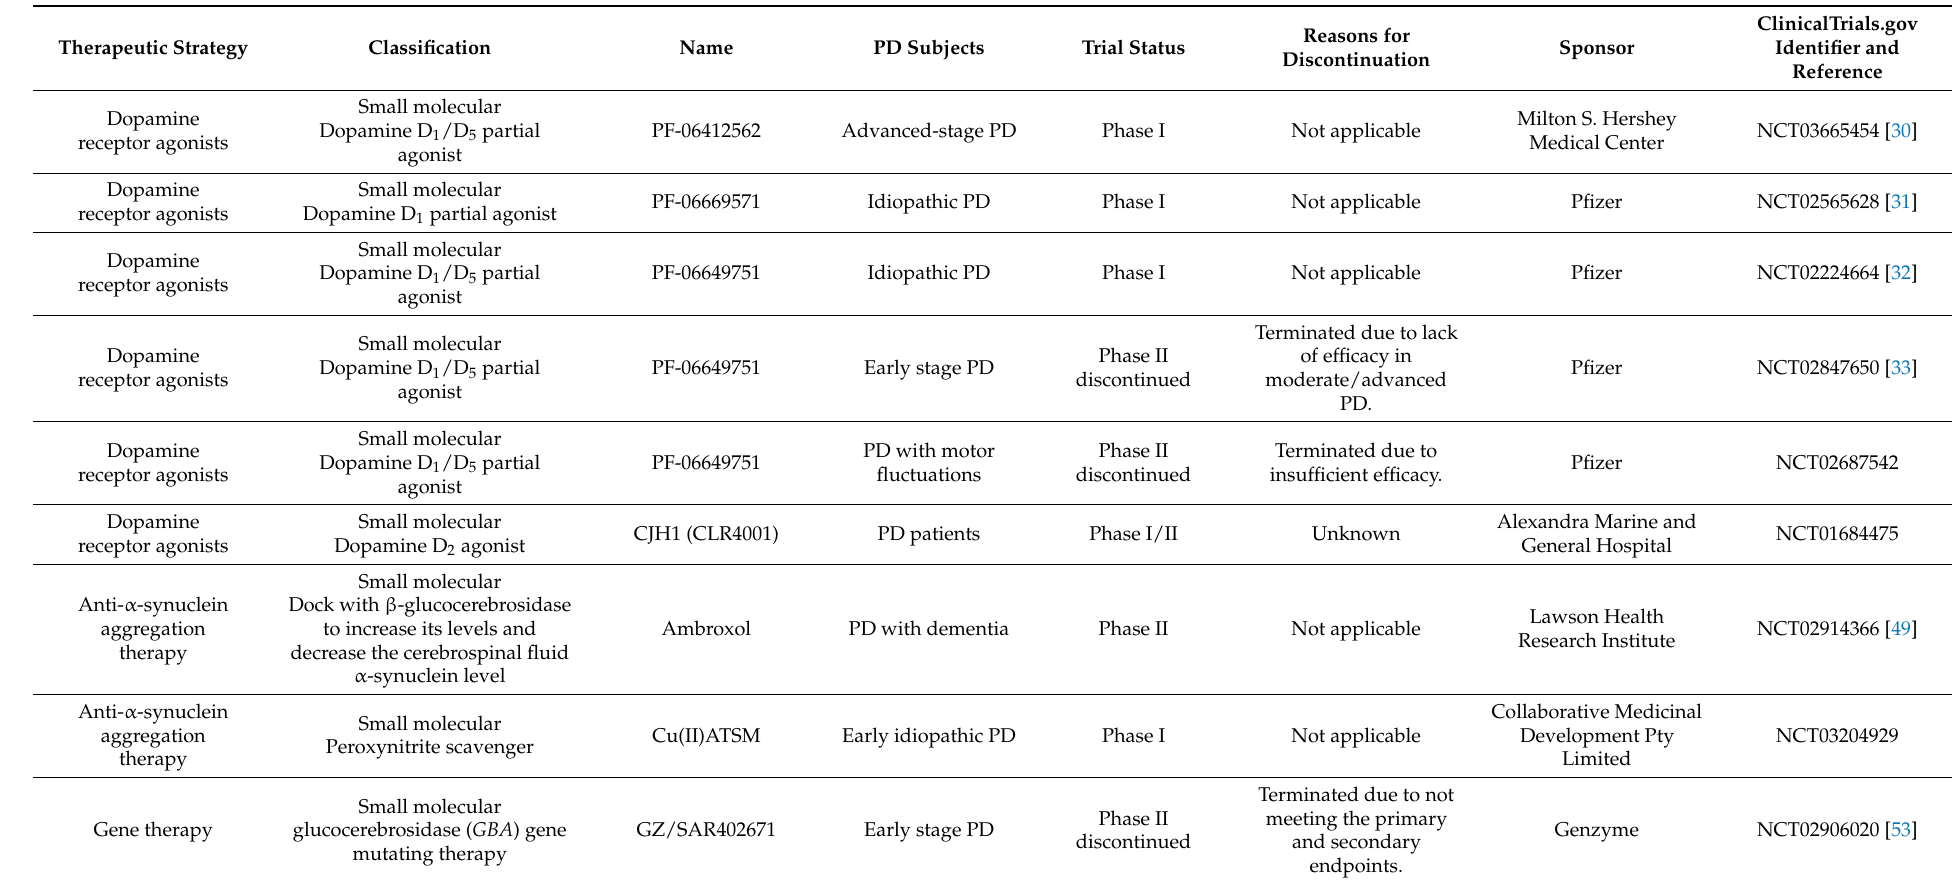
Table 1. Small molecule drugs in phase I, II, or III clinical trials for PD treatment. The data are based on the trial status (ongoing, updated, or discontinued) on ClinicalTrials.gov (https://clinicaltrials.gov) that is active as of 16 June